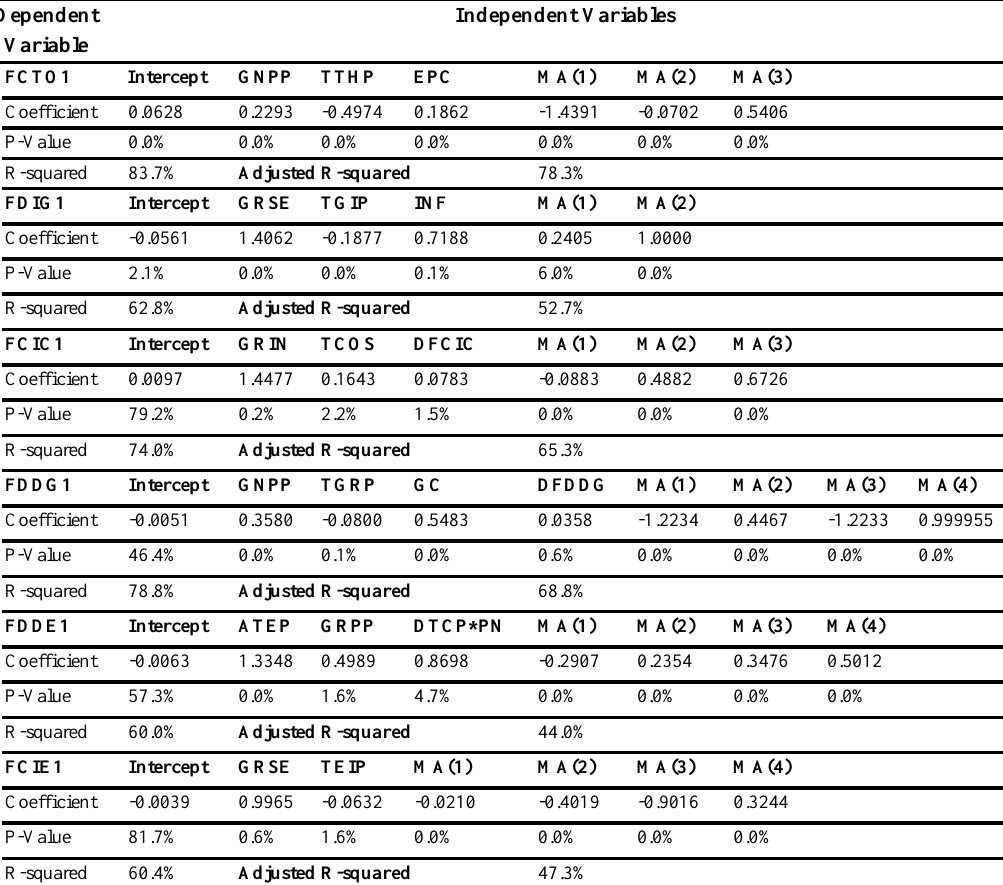
Table.5.Estimation